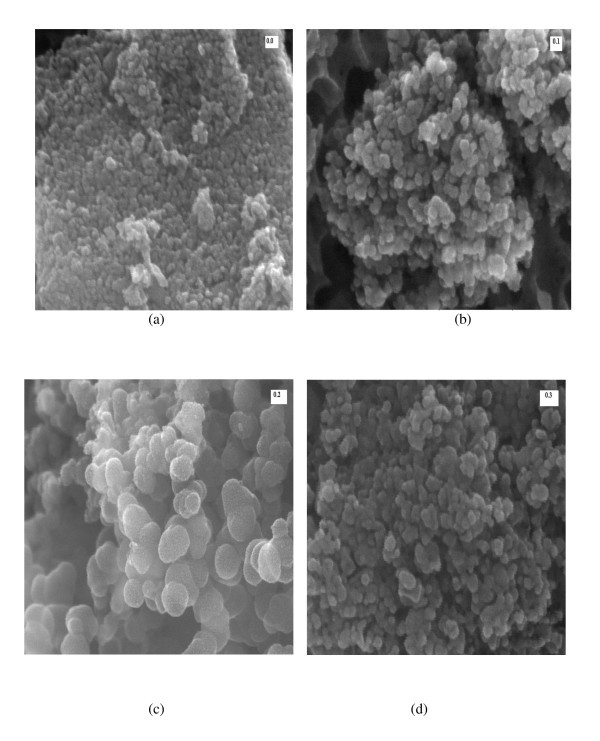
SEM micrographs of Ni0.2Cd0.3Fe2.5 - xAlxO4 (0.0 ≤ x ≤ 0.5) ferrite nanoparticles.